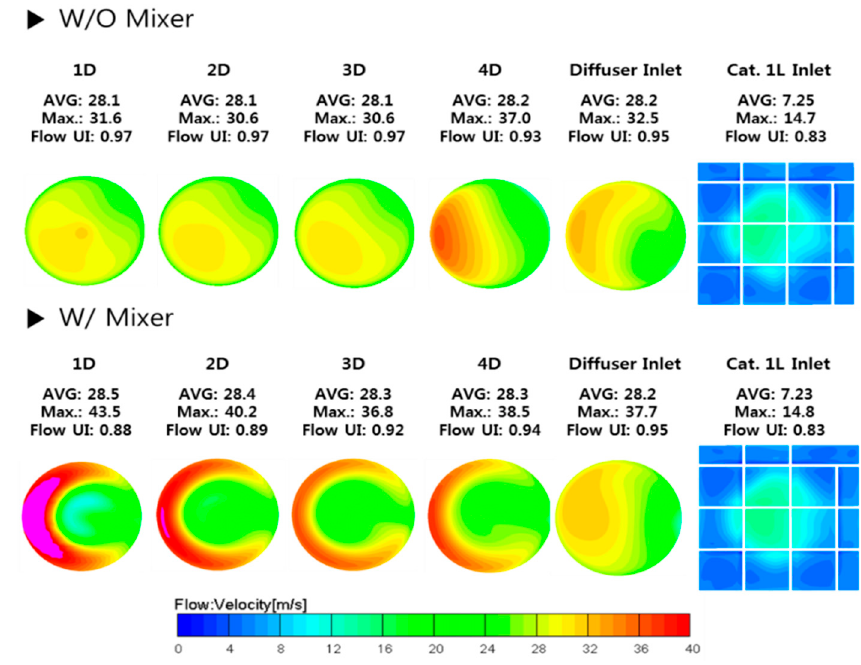
Figure 9. Distribution of mean velocity at specific locations with and without mixer.